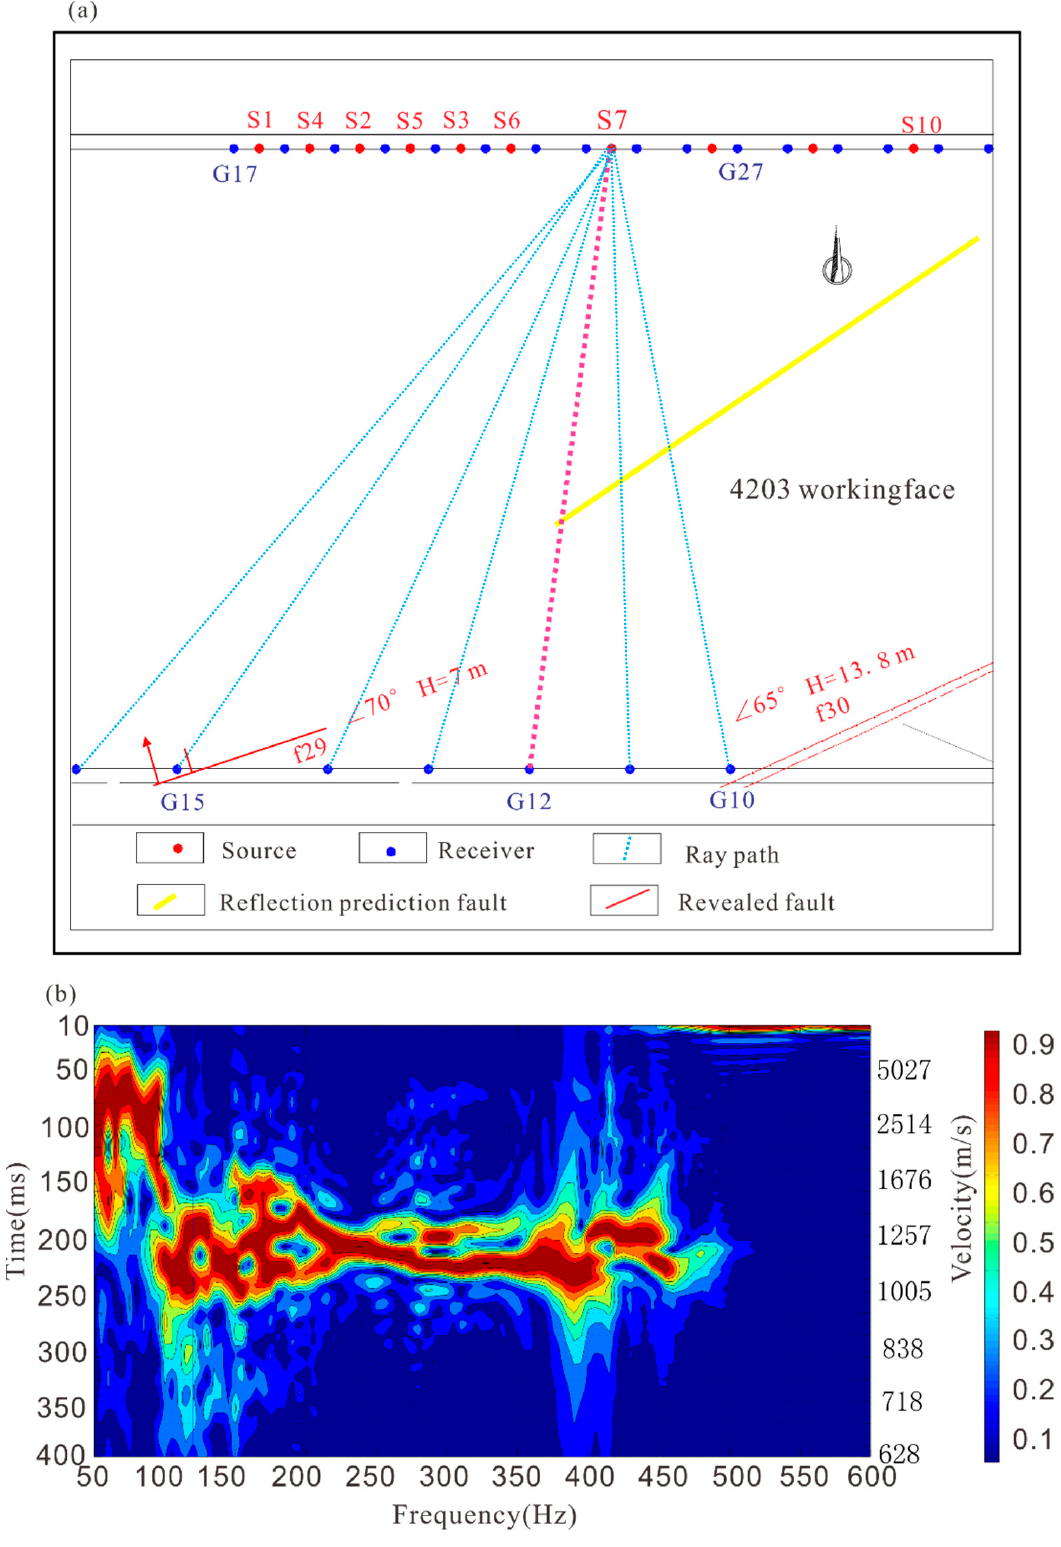
Figure 6. ( a ) S7-12 ray path; ( b ) S7-12 dispersion map for a known reflective fault surface.